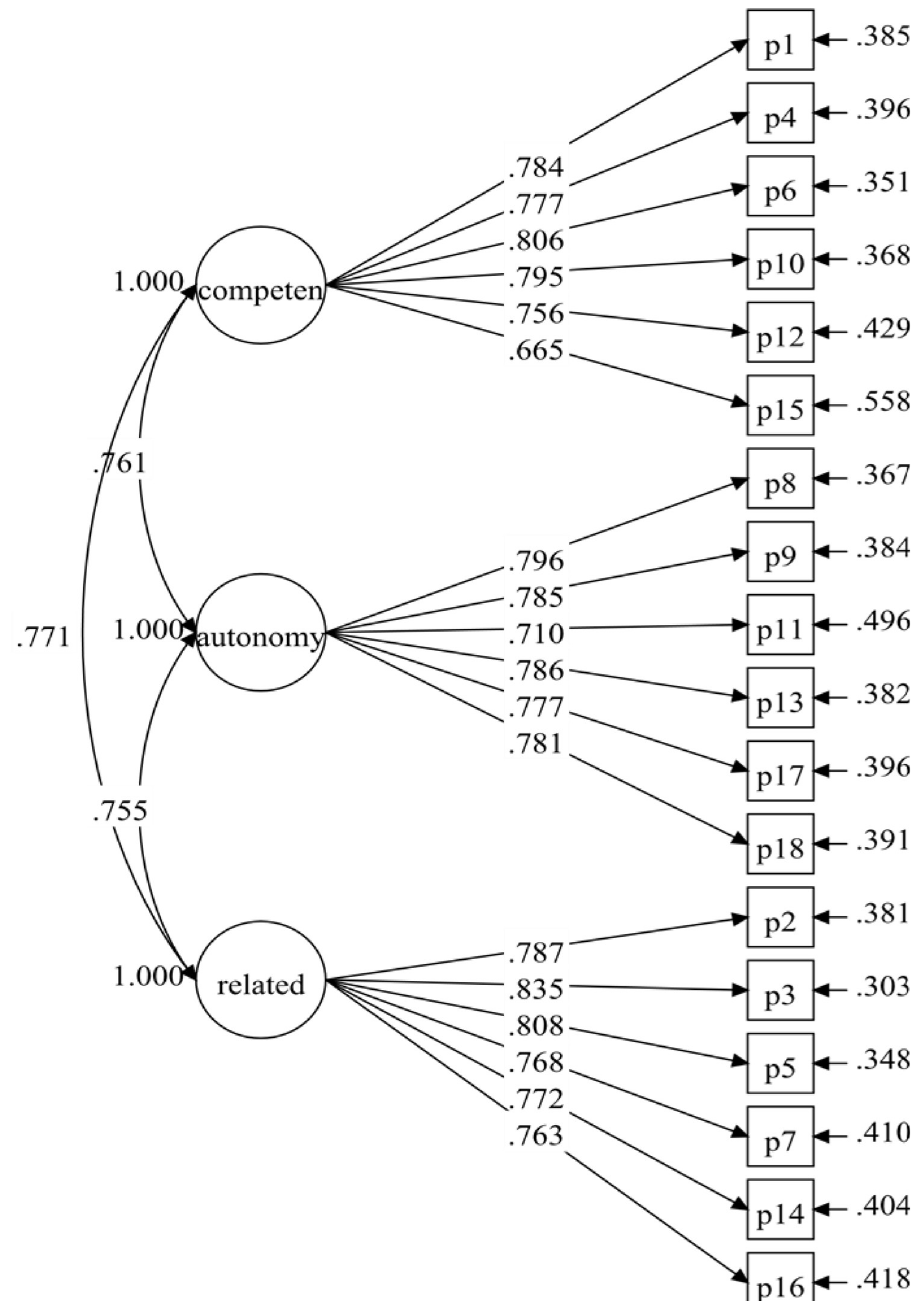
Fig 1. PNSE-M model